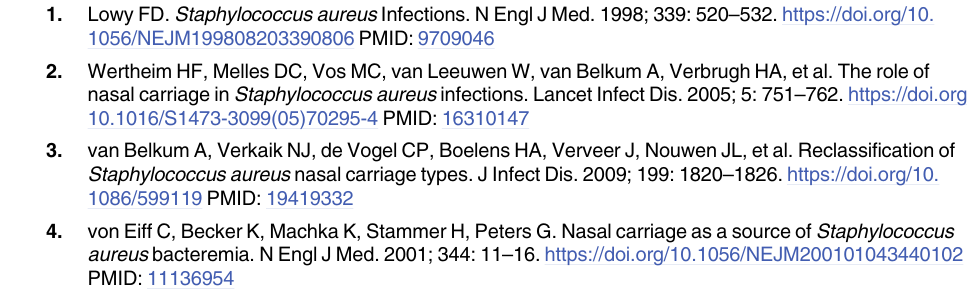
S1 Fig. Sampling moments and results for each pig farm worker. Log counts of Staphylococcus aureus and methicillin-resistant S . aureus and distribution of com- munity state types (CSTs) among pig farm workers are shown. The dashed line indicates the limit of CFU